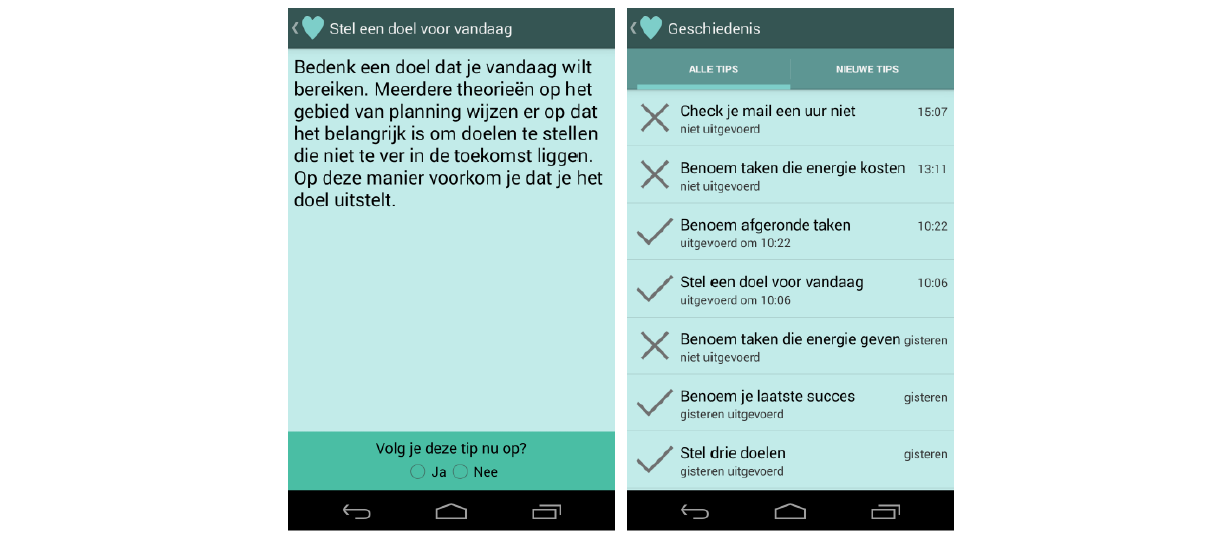
Figure 12. The SWELL NiceWork